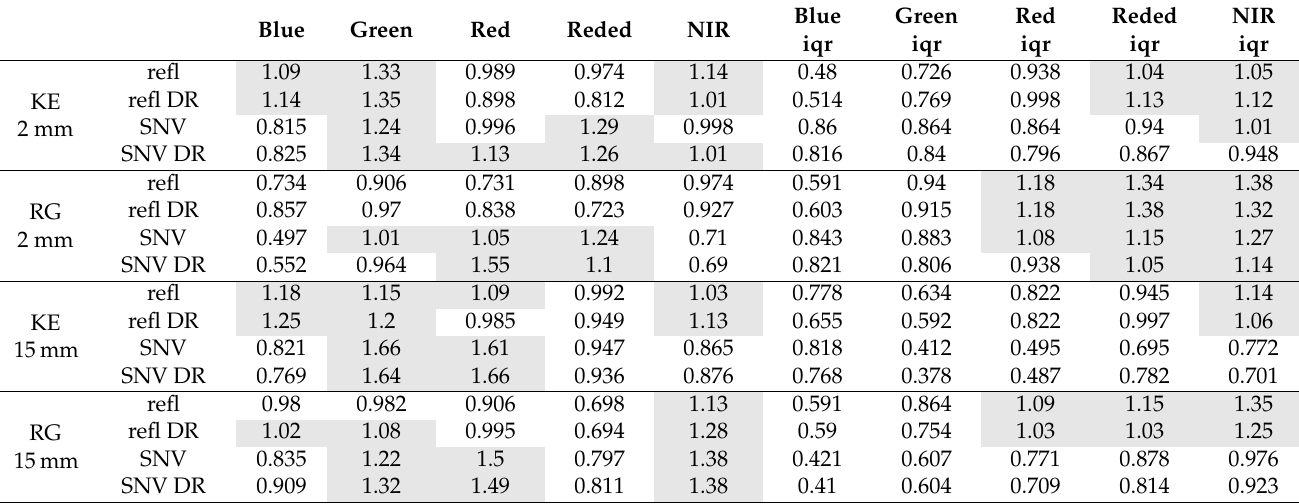
Table 1. VIP scores from the multispectral data PLSR models of kinetic energy (KE) and roughness (RG) at the two different resolutions. VIP scores higher than 1 are marked with grey colour